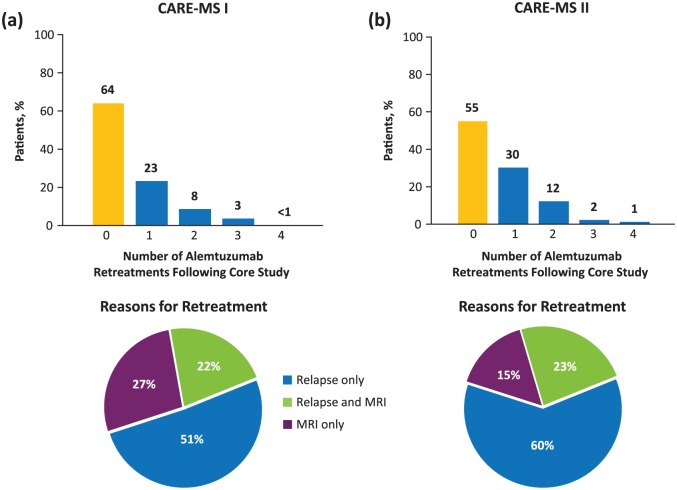
Through Year 6 of the CARE-MS extension, in cohorts of patients entering from (a) CARE-MS I and (b) CARE-MS II, the majority of patients received no further alemtuzumab after their second course.4,5CARE-MS, Comparison of Alemtuzumab and Rebif® Efficacy in Multiple Sclerosis; DMT, disease-modifying therapy; MRI, magnetic resonance imaging.